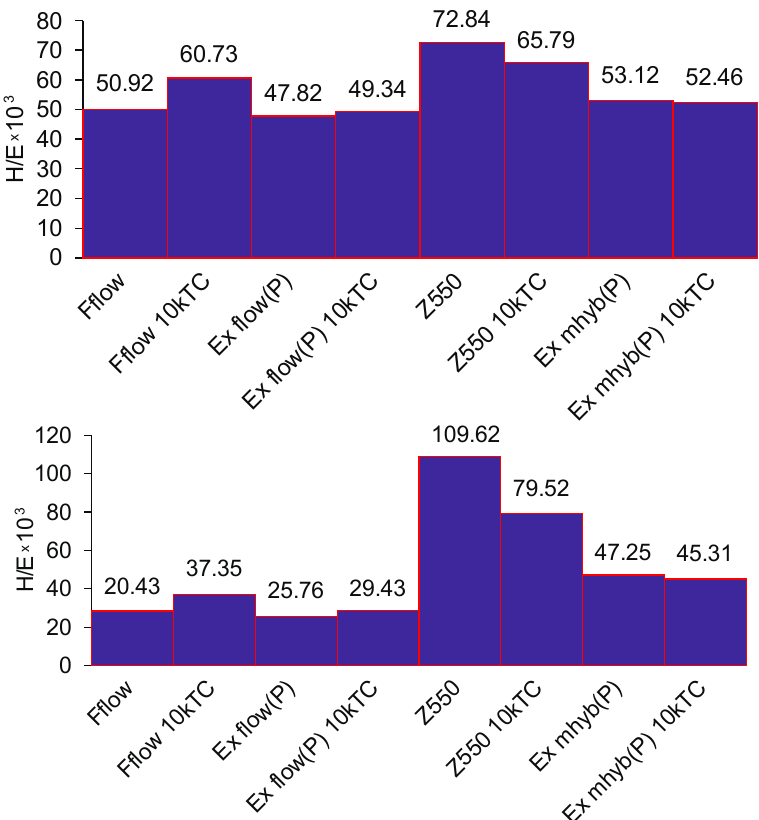
Figure 3. H/E and H 2 /E average values for dental composite in relation to thermocycling. Figure 3. H / E and H 2 / E average values for dental composite in relation to thermocycling.